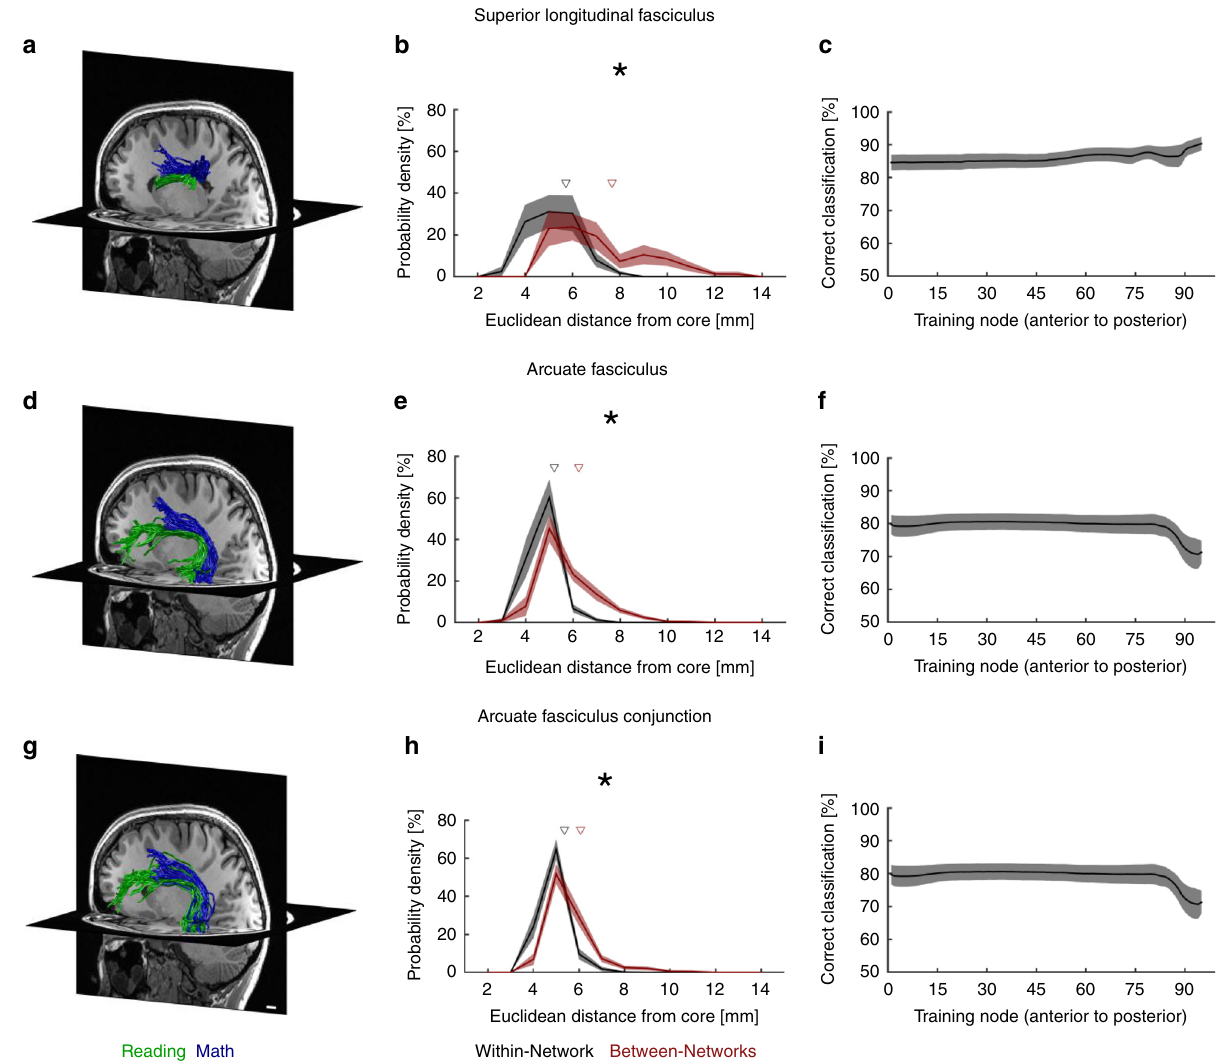
Fig. 4 Pairwise connections of the reading and math networks are segregated and parallel in the SLF and the AF. a – c : SLF tracts connecting IFG and SMGr in the reading network and PCS and SMGm in the math network. d – f : AF tracts connecting the IFG and STS in the reading network and the PCS and ITG in the math network. g , h : AF tracts connecting the lOTC conjunction fROI with the IFG in the reading network and the PCS in the math network. a , d , g : Math (blue) and reading (green) tracts of the SLF and AF presented in the left hemisphere of a representative individual subject showing the spatial segregation of these tracts. Scale bar in g indicates 1 cm. b , e , h : Euclidean distance in millimeter (derived from x,y,z coordinates) of all tracts relative to the core (mean) tract, within-network (black) and between-networks (maroon). The distance was calculated across all tracts; the histograms show the distribution of distances across all nodes in each subject ± SEM. Upside-down triangles: Mean distance across nodes and subjects. Asterisk: Mean distances differ signi fi cantly, p < 0.05 (paired t -test). c , f , i : Performance of a linear SVM classifying math and reading tracts within the SLF and AF based on their